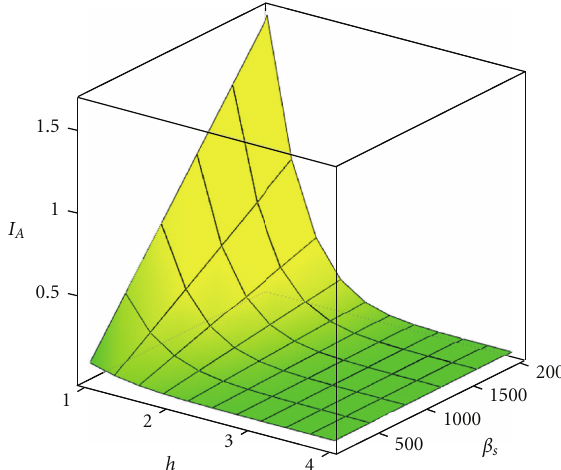
Figure 9: I A ( h , β s ) for w c = 100 ( ψ = 0 . 1), Elastic